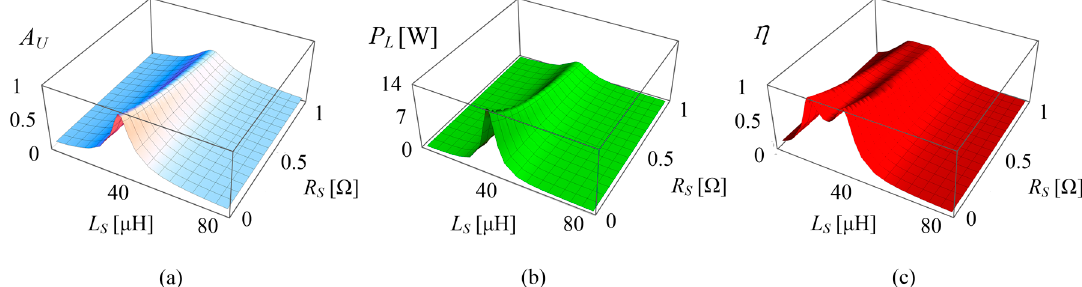
Figure 13. ( a ) Surface diagram of voltage gain related to mooring cable’s impedance; ( b ) Surface diagram of power related to mooring cable’s impedance; ( c ) Surface diagram of efficiency to mooring cable’s impedance. ( A U : voltage gain; P L : power; η : efficiency; L S : inductance of the mooring cable; R S : resistance of the mooring cable).